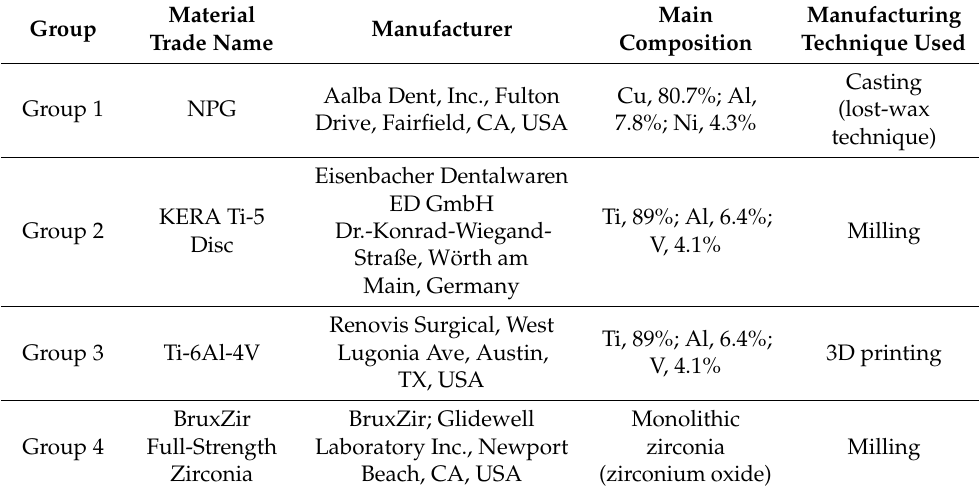
Table 1. Commercial names and details of materials used in the study.